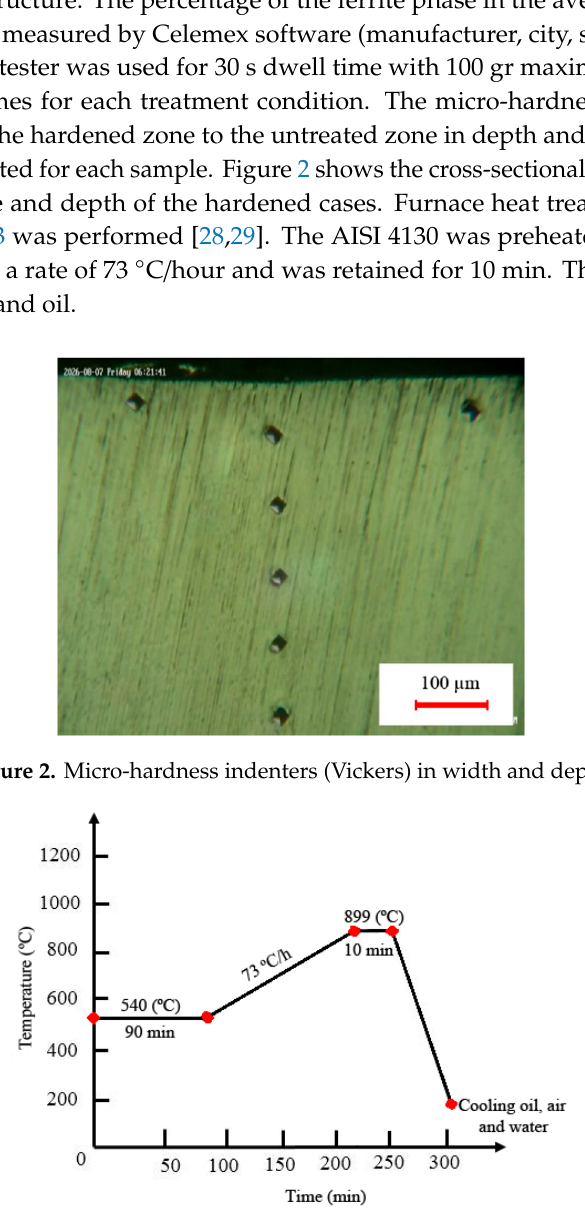
Figure 3. The cycle of AISI 4130 of furnace hardening heat treatment [27].